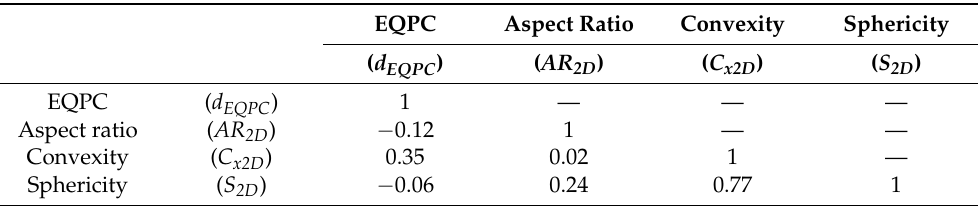
Table 5. Two-dimensional shape parameter correlation coefficients.